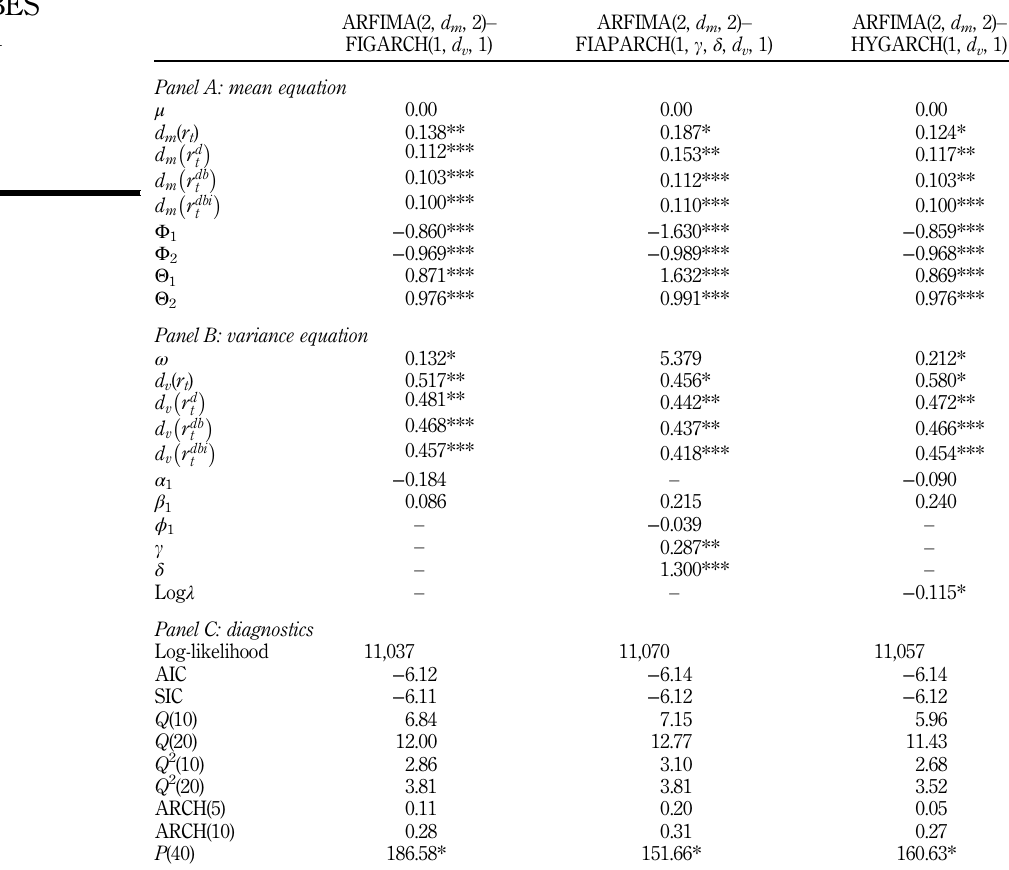
Table V. Long-memory model